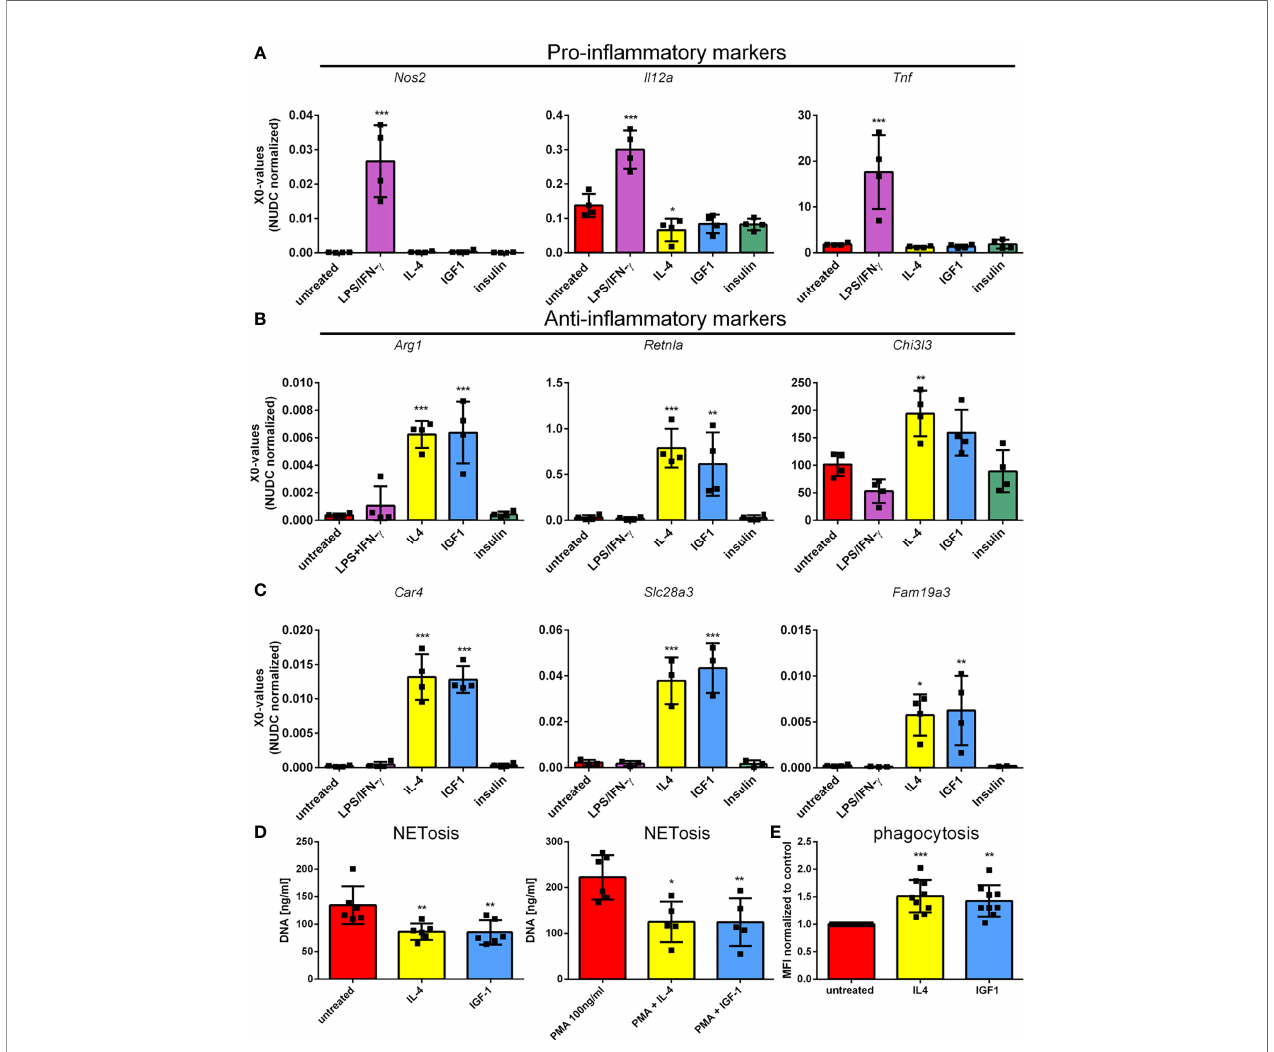
FIGURE 2 | IGF1, but not insulin, polarizes neutrophils to a N2-like phenotype Bone marrow derived neutrophils were left untreated or treated 4 hours with LPS/ IFN g (10/2 ng/mL), IL4 (20 ng/mL), IGF1 (10 ng/mL) or insulin (10 ng/mL) and pro-in fl ammatory marker (A) , anti-in fl ammatory marker (B) , and the highest upregulated genes observed in RNAseq (C) expression was assessed by quantitative RT-PCR. (D) DNA content in supernatant was measured as a measure for NETosis, in the absence and presence of 100 ng/mL phorbol 12-myristate 13-acetate (PMA). (E) Phagocytosis of fl uorescently labeled Staphylococcus aureus normalized to untreated neutrophils. LPS, Lipopolysaccharide; IFN g , interferon-gamma; IL4, Interleukin 4; IGF1, Insulin-like growth factor 1; Nos2 , nitric oxide synthase 2; Il12a , Interleukin 12a; Tnf , Tumor necrosis factor; Arg1 , Arginase 1; Retnla , resistin like alpha; Chi3l3 , chitinase-3-like 3. X0 values normalized to Nudc (nudC nuclear distribution protein) expression of single measurements are shown. Bars represent mean ± SD. *p<0.05, **p<0.01,